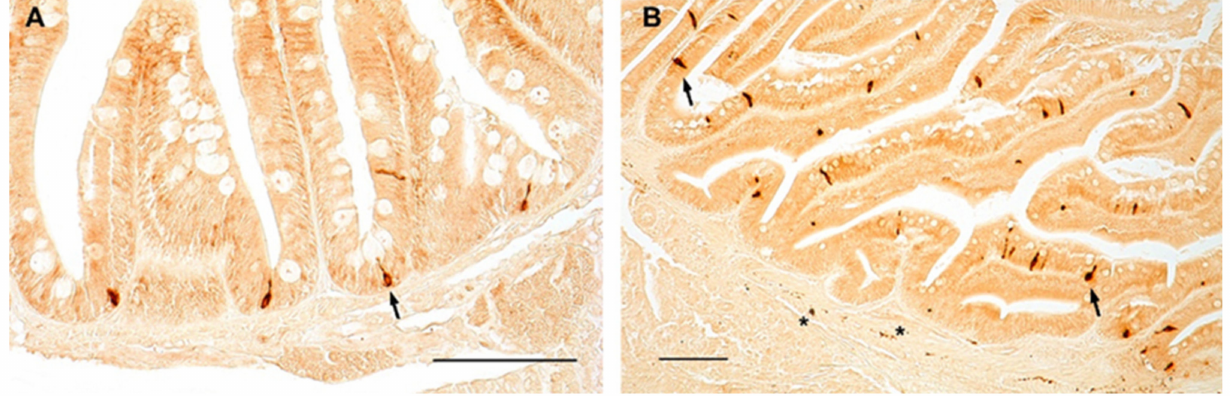
Figure 4. NPY immunoreactivity in the foregut of zebrafish. Transverse sections of the foregut of 6-month-old zebrafish showing NPY immunopositivity in the cytoplasm of enteroendocrine cells (arrows) ( A , B ) and in varicosities in the myenteric plexus (asterisks) ( B